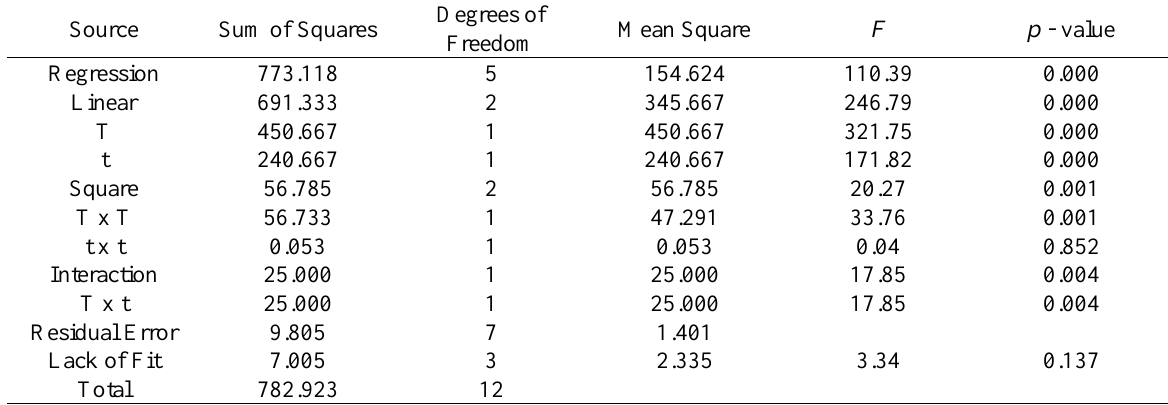
Table 3. Analysis of variance for boride layer thickness.